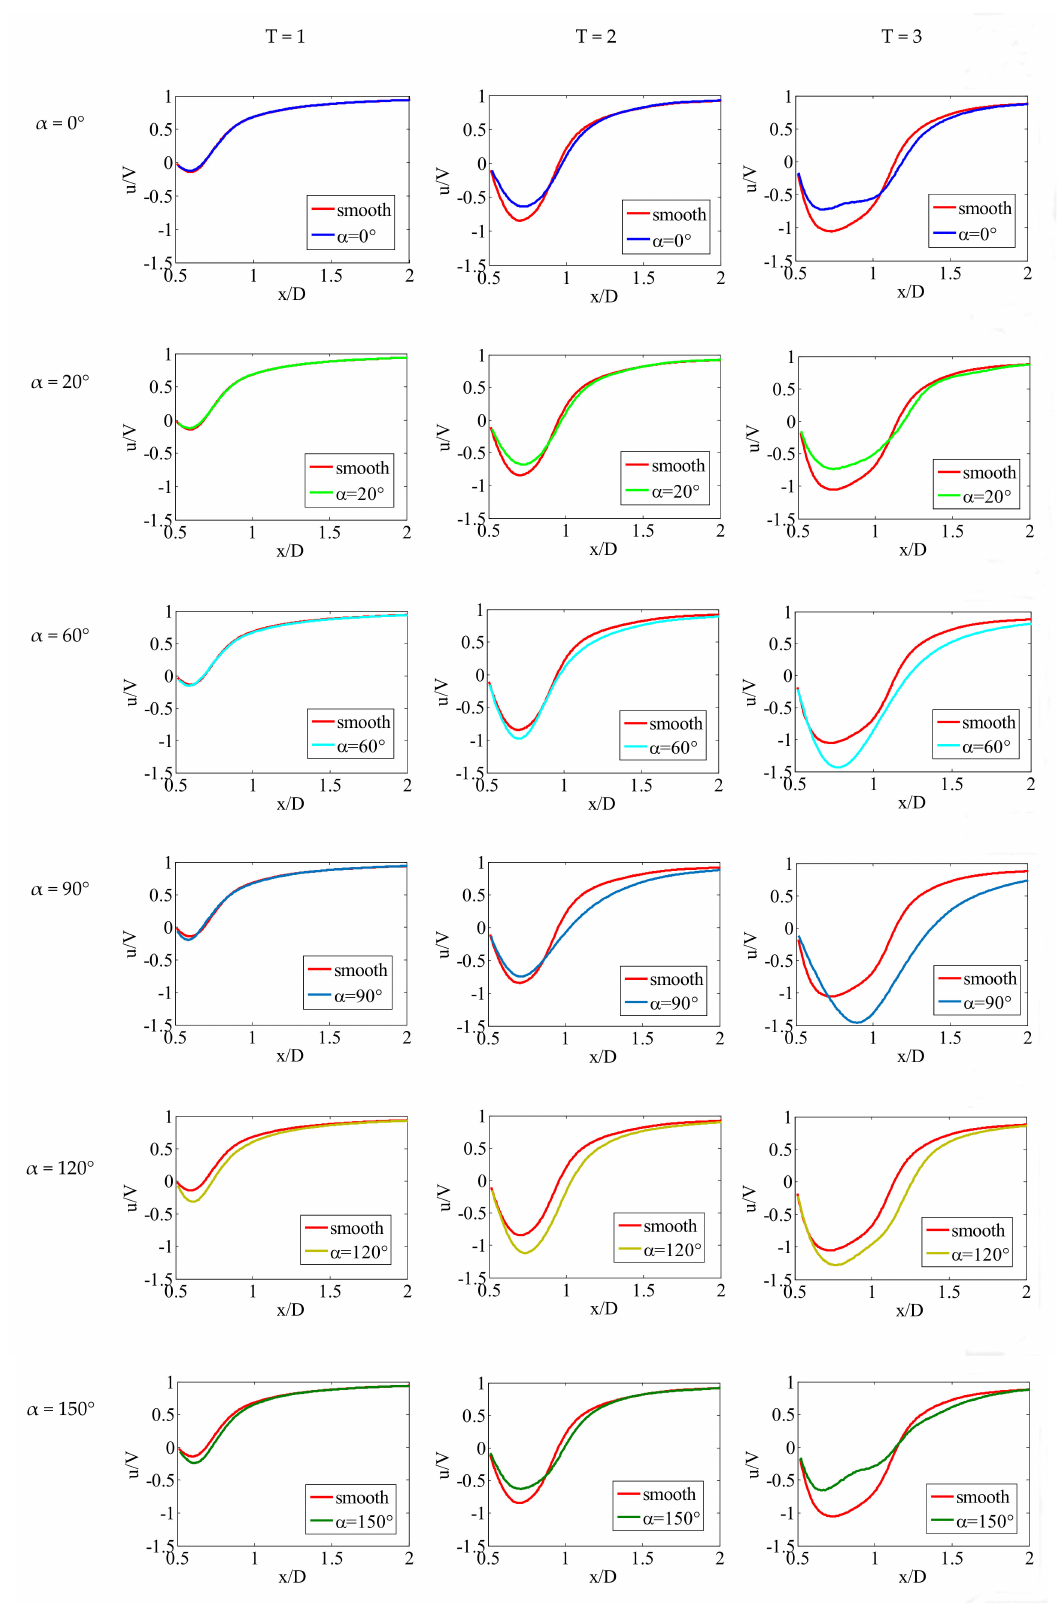
Figure 11. The comparison of the velocity distribution at di ff erent moments on the axis between the smooth cylinder and cylinder with strips for Re =